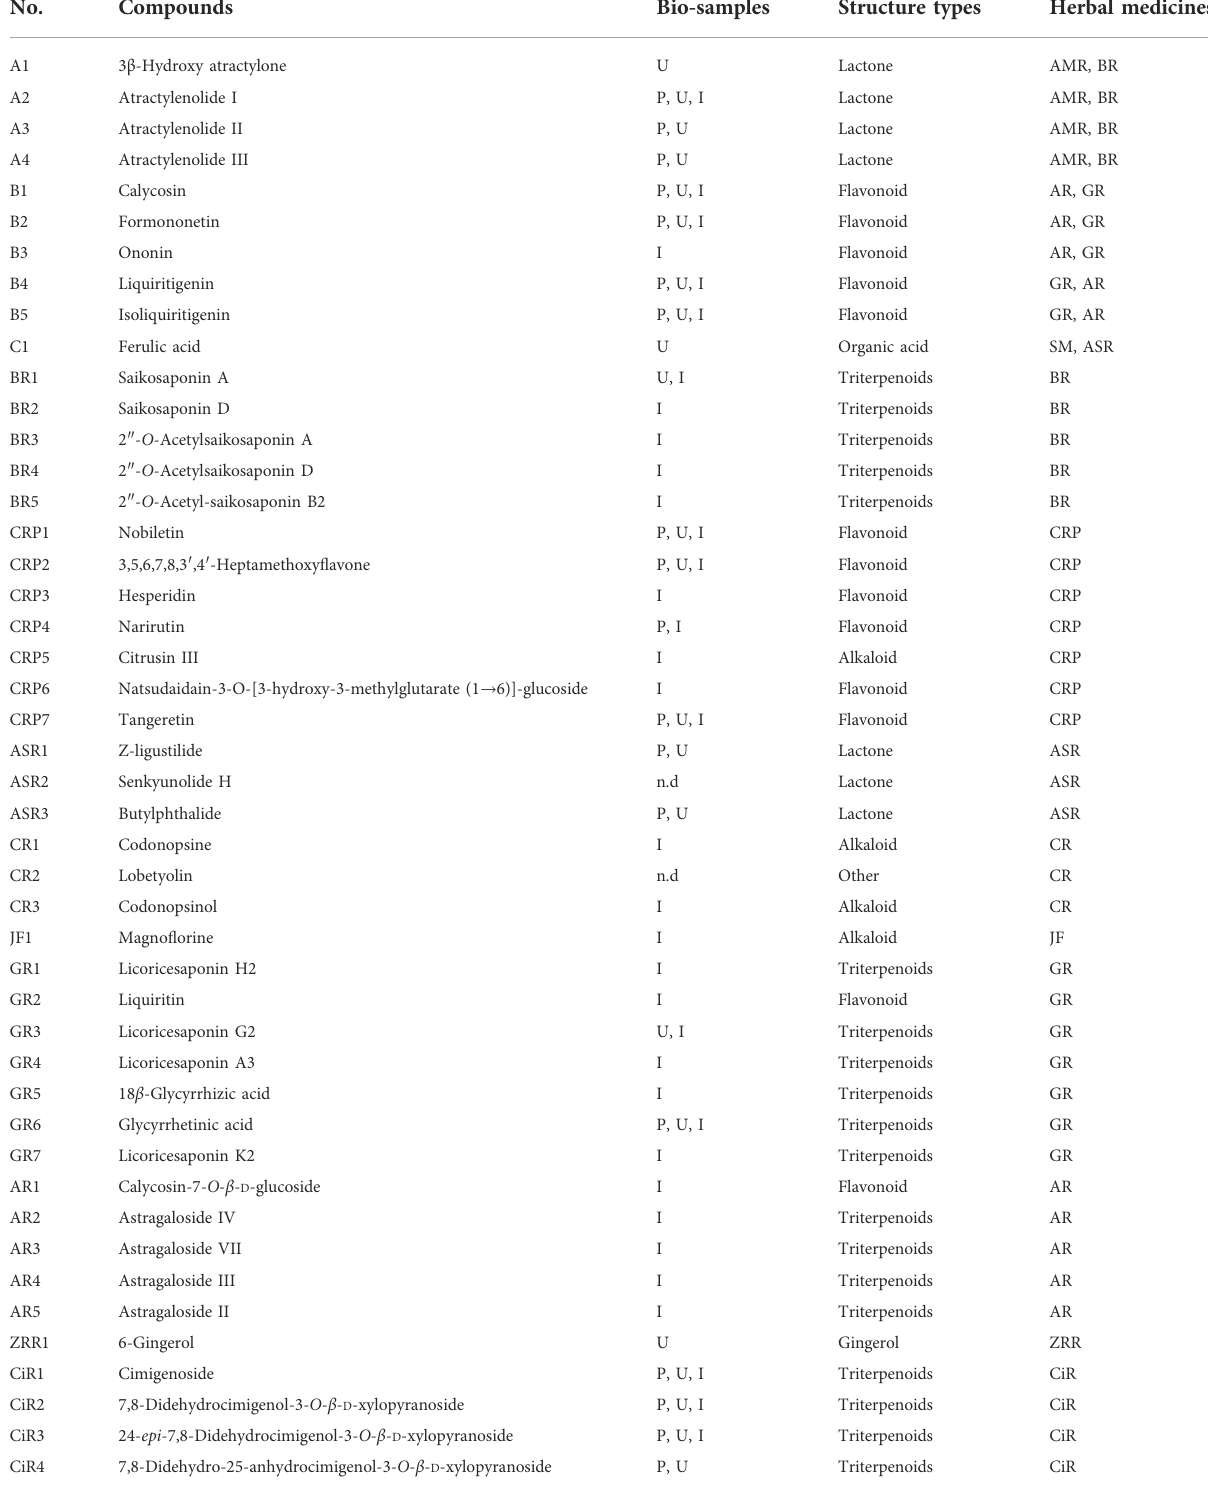
TABLE 1 Detailed information of 46 potential bioactive components of BZYQT.